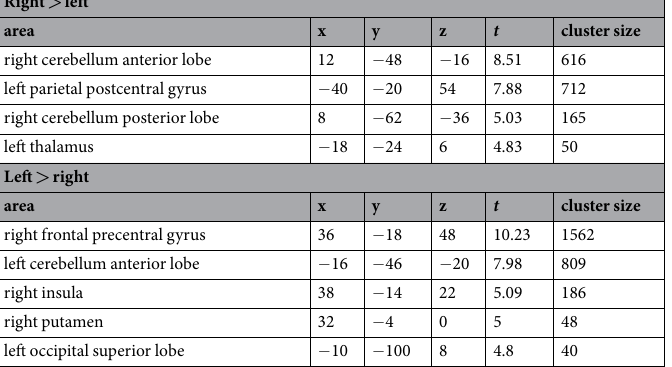
Table 1. Summary of the finger localizer image results. Finger localizer contrasts were thresholded at p < 0.001 (uncorrected) with a cluster extent of k = 36, corresponding to a Family-Wise Error (FWE) correction for multiple comparisons of p < 0.05 at the cluster